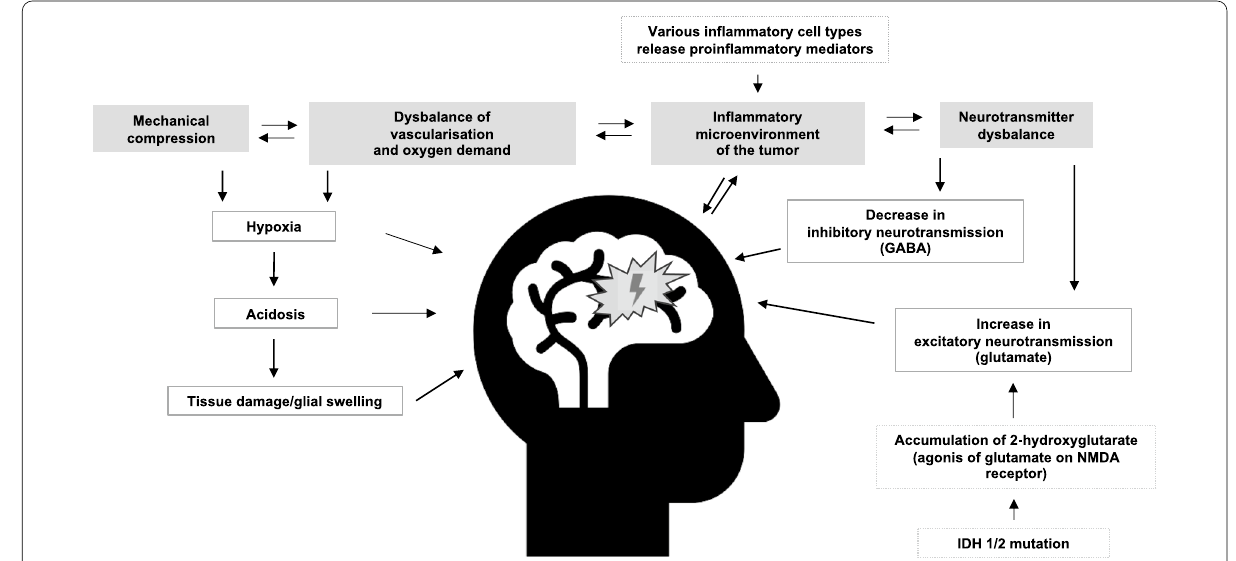
Fig. 1 Overview of mechanisms driving brain tumor related epilepsy